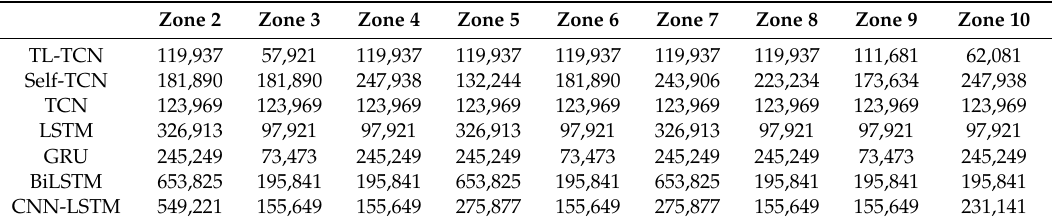
Table 11. The complexity of the transfer learning framework and other